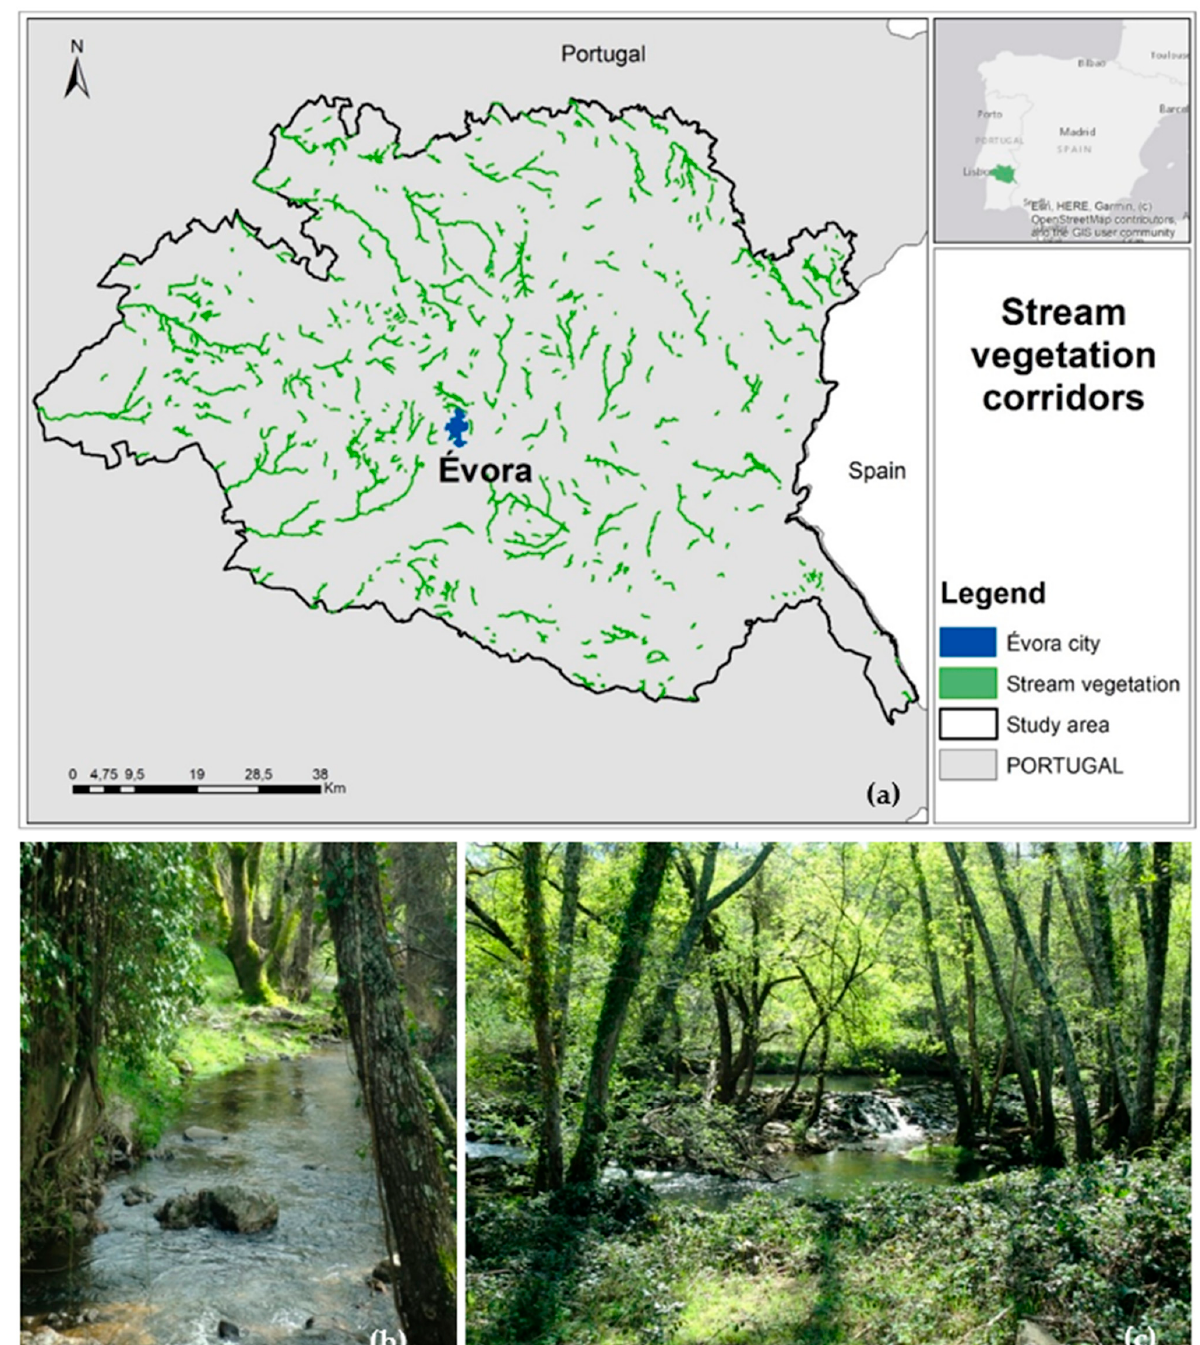
Figure 4. Vegetation stream corridors in the study area (author of the map ( a ) and photos ( b ) and ( c ): T. Batista). Non ‐ intrinsic vegetation criteria were also applied, such as historical record, scien ‐ tific and educational potential, interest and recreational potential interest, although these criteria has been assumed with lower weighting coefficients. The entire study area was considered to have high scientific and educational potential, high recreational interest, as well has a high historical record. As these criteria are often difficult to measure, a subjec ‐ tive appreciation was made based on the experience of one of the authors that is an expert